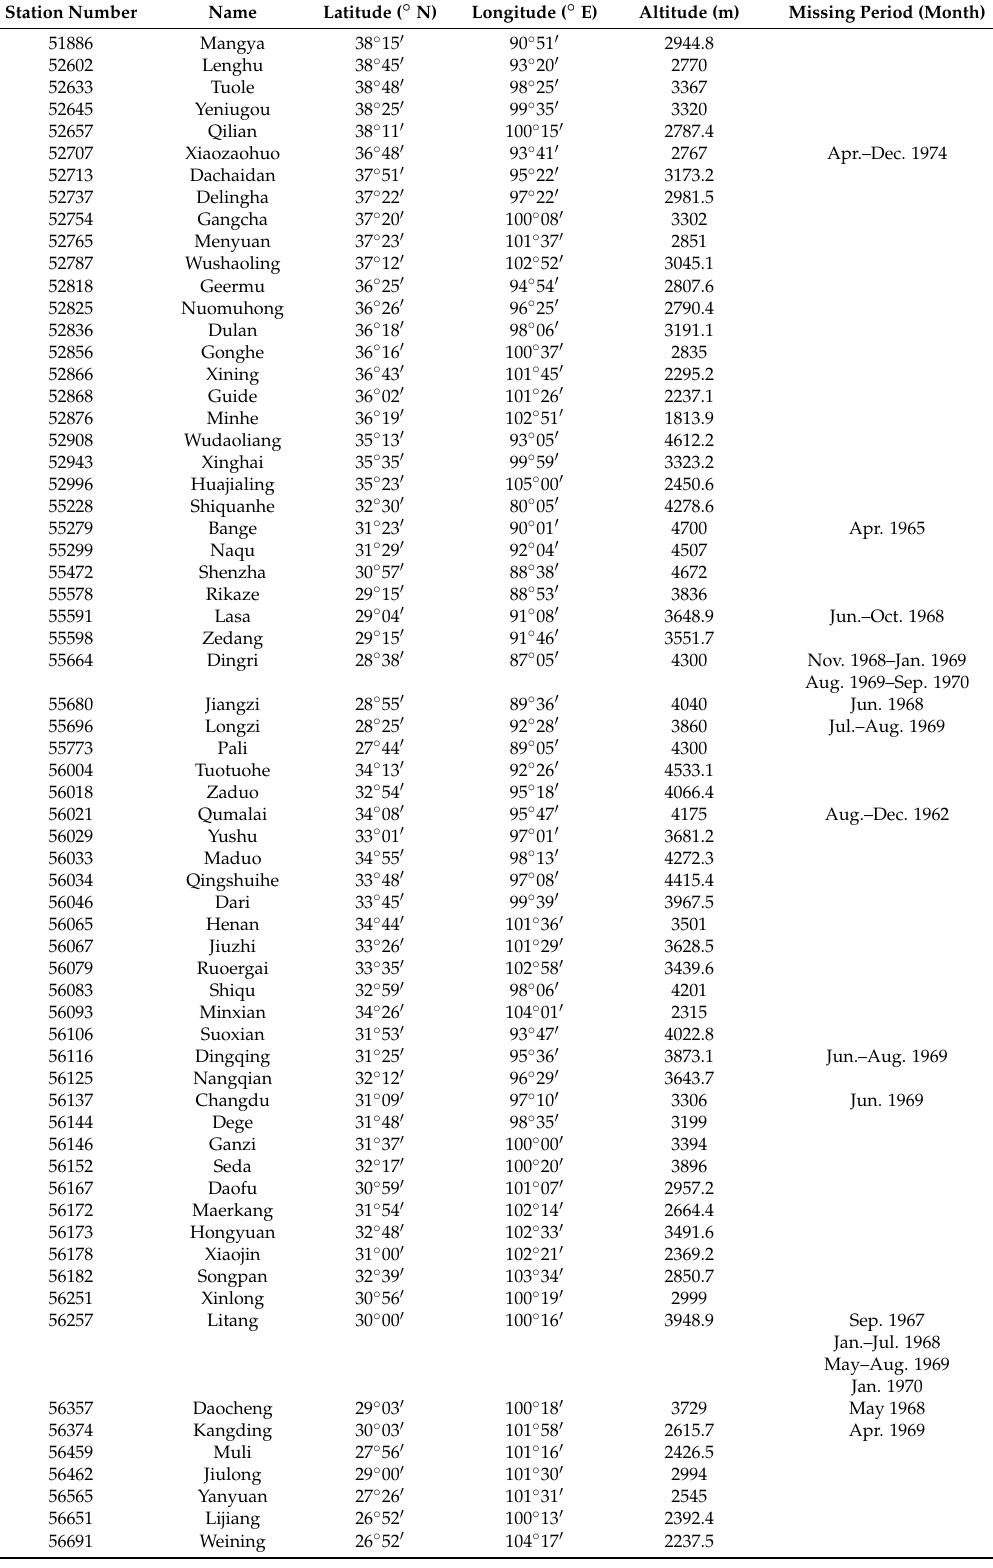
Table 1. Detailed information of the selected